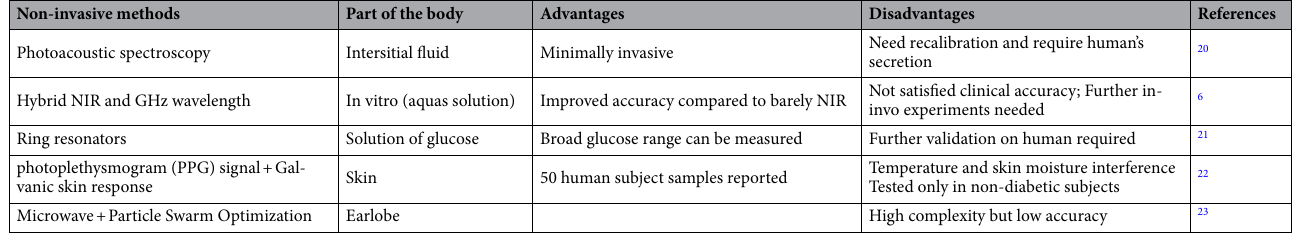
Table 2. Non-invasive blood glucose approaches in